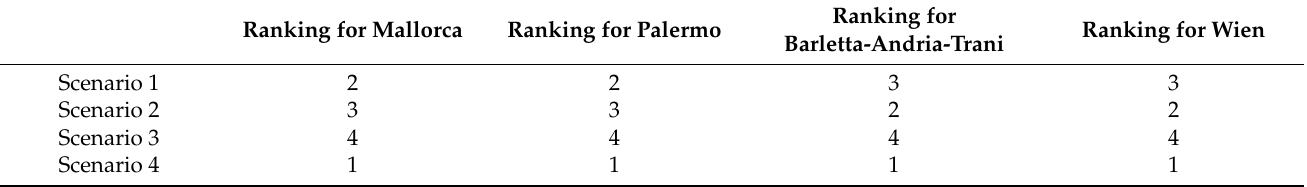
Table 9. Scenario ranking table for Autodesk Revit, Insight, and Green Building Studio’s energy results. Ranking for Mallorca Ranking for Palermo